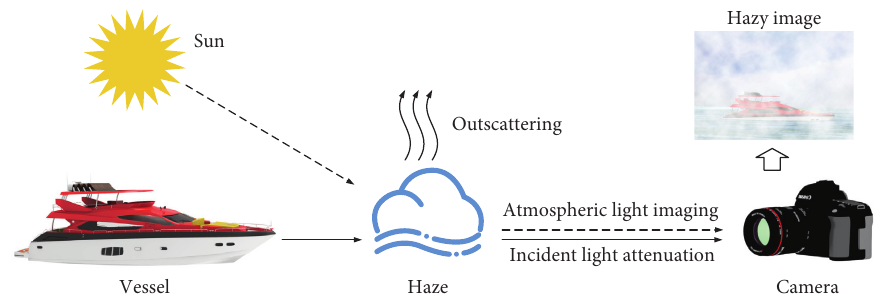
Figure 2: The principle of the atmospheric scattering